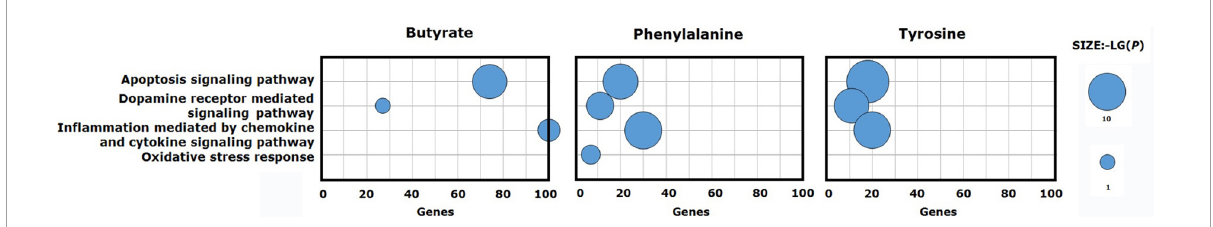
FIGURE4 Signaling pathways enriched for validated metabolite gene sets. Phenylalanine impacting gene set was enriched for the four main pathways. Butyrate and tyrosine impacting gene sets were enriched for three of the four main pathways.